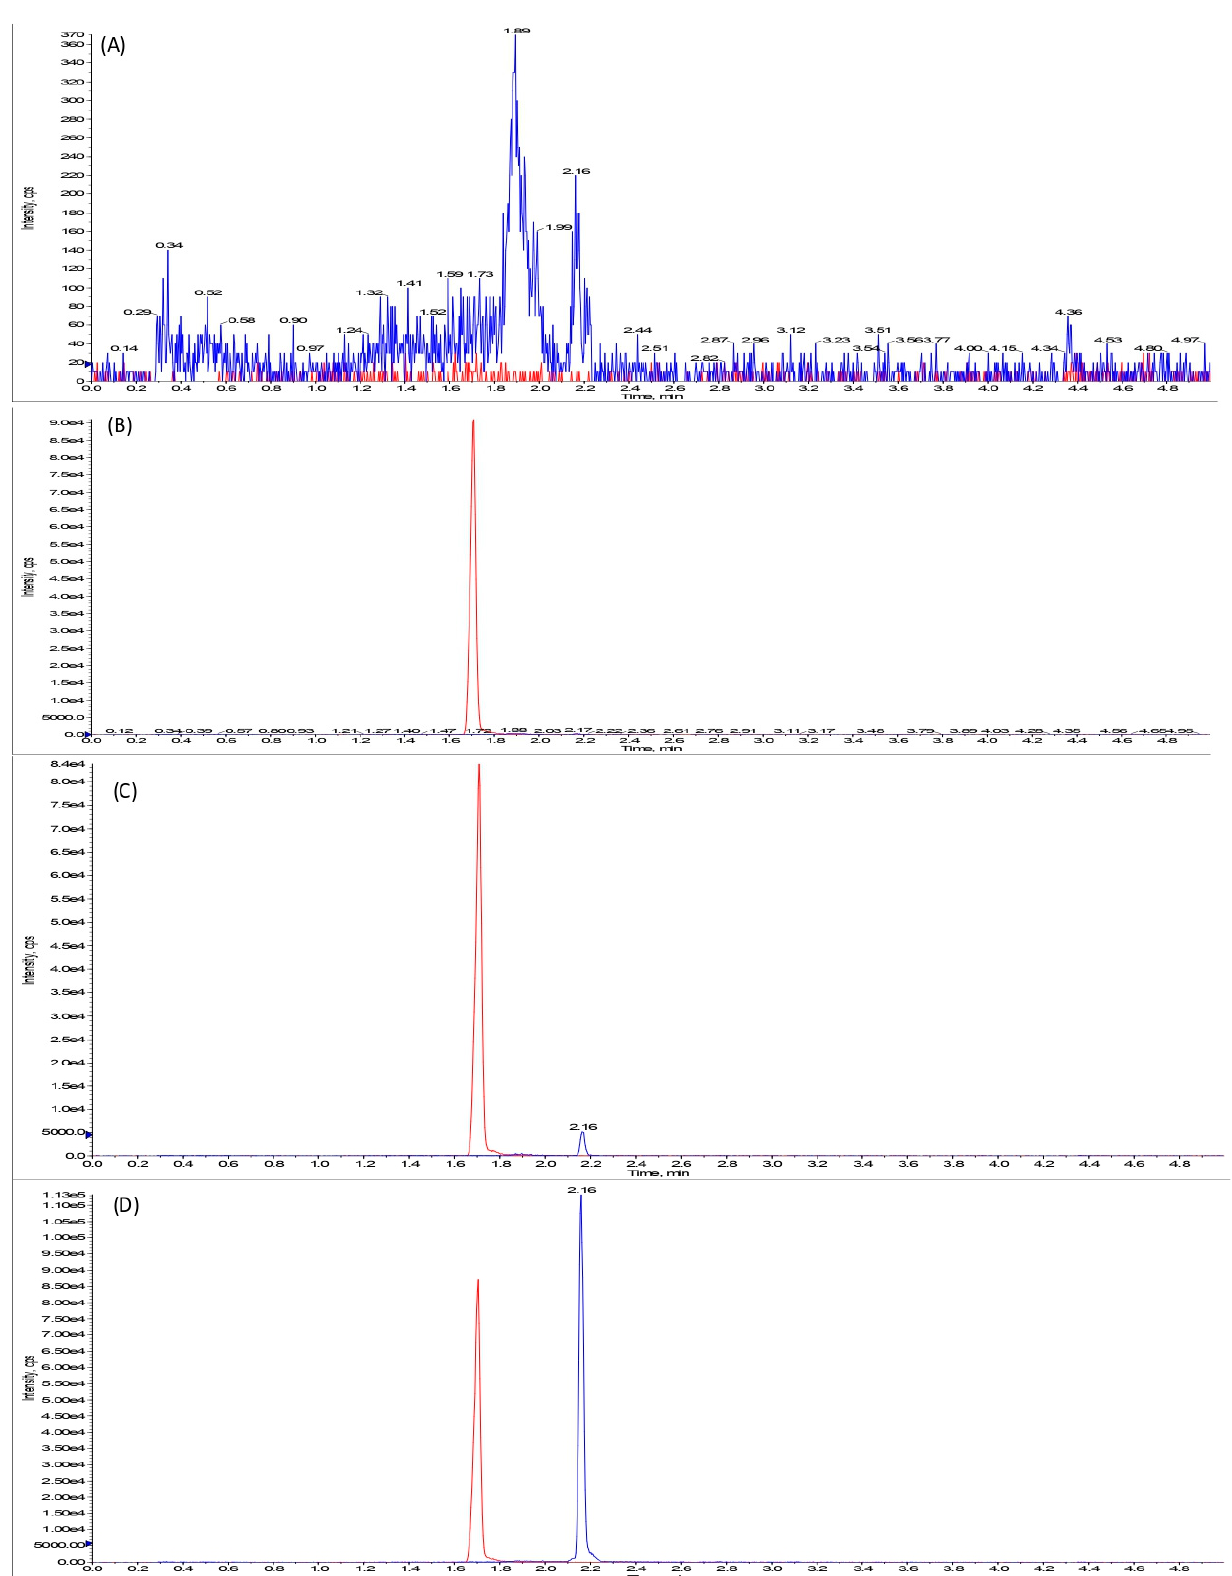
Figure 3. Representative chromatograms of OJT007 and voriconazole (IS) in rat plasma: ( A ) blank rat plasma; ( B ) blank rat plasma spiked with IS; ( C ) blank rat plasma spiked with IS and OJT007 at 5 ng/mL; ( D ) blank rat plasma spiked with IS and OJT007 at 100 ng/mL.